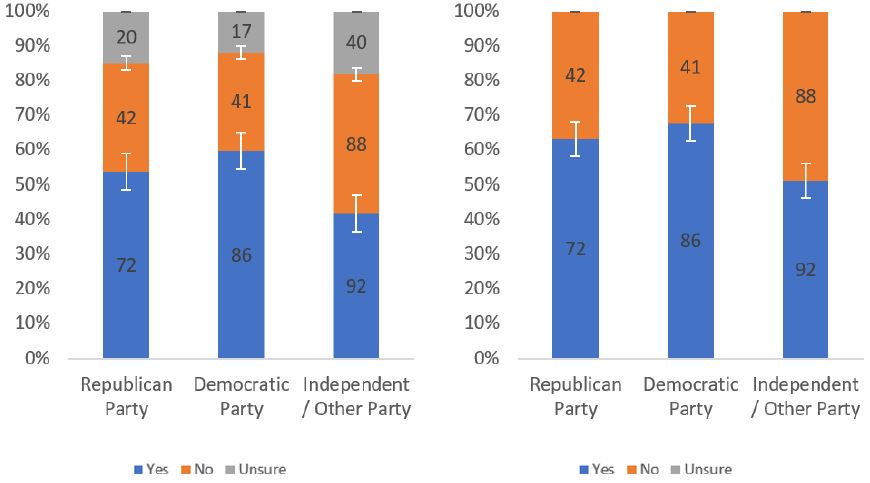
Figure 62. Responses regarding respondents’ willingness to review by party affiliation including ( left ) and excluding ( right ) unsure responses.